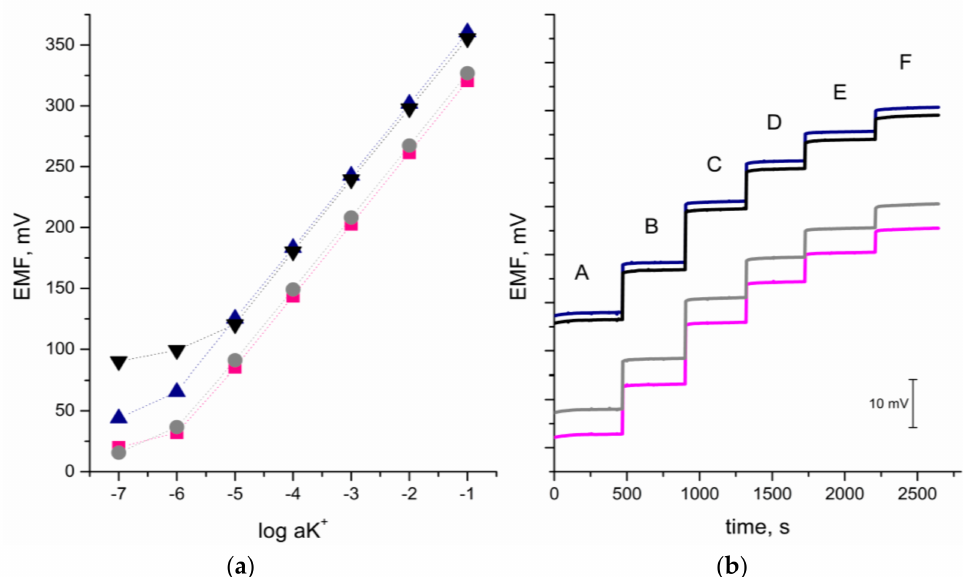
Figure 8. Exemplary potentiometric response of GC/CB + RuO 2 /K + -ISM ( (cid:4) ), GC/NT + RuO 2 /K + -ISM ( • ), GC/GR + RuO 2 /K + -ISM ( (cid:78) ), and GC/K + -ISM ( (cid:72) ) electrodes. ( a )—tested for standard K + solutions from 10 − 6 to 10 − 1 M, ( b )—tested for standard solutions between 10 − 3 and 10 − 2 M (A—0.001 M, B—0.002 M, C—0.004, D—0.006 and E—0.008 M, F—0.01